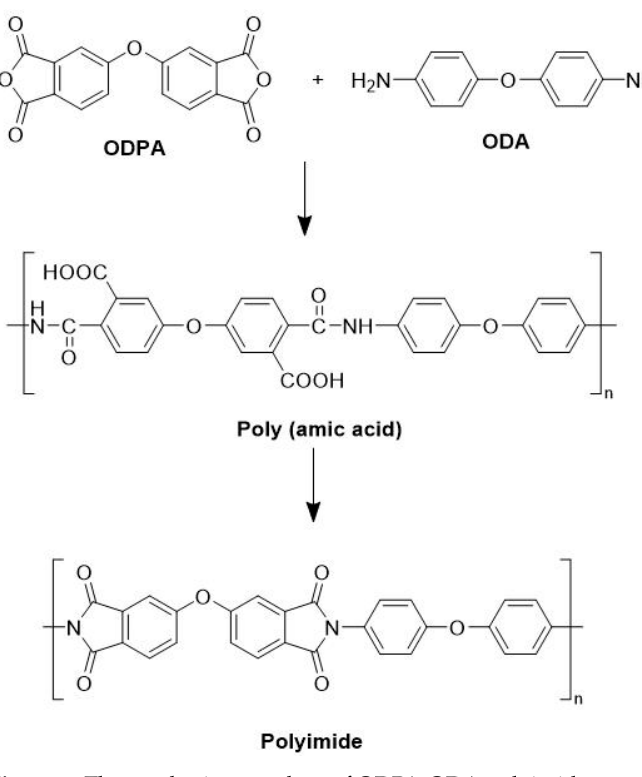
Figure 1. The synthesis procedure of ODPA-ODA polyimide.